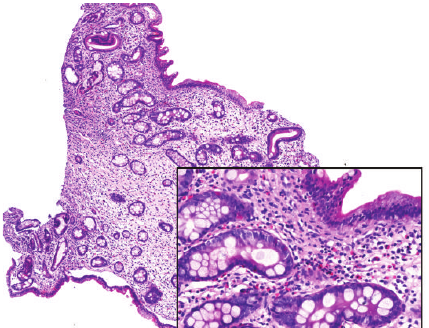
Figure 10: Nonpolypoid jejunal mucosa shows irregularly shaped crypts, edema, and inflammation (hematoxylin-eosin, original magnification 6x). Inset: flattened mucosal surface without villi (hematoxylin-eosin, original magnification 20x).